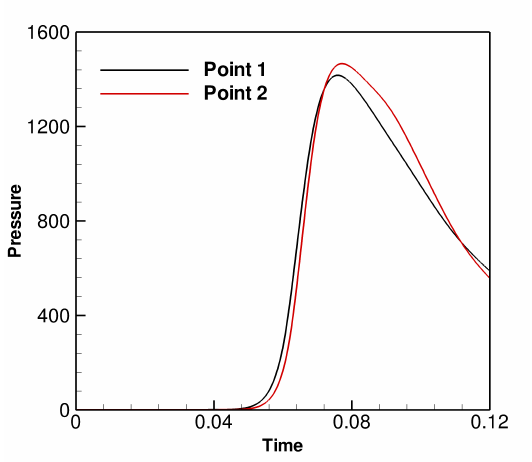
Figure 6. The pressure history recorded at the boundaries of the computational domain for an initially cylindrical bubble (Scenario